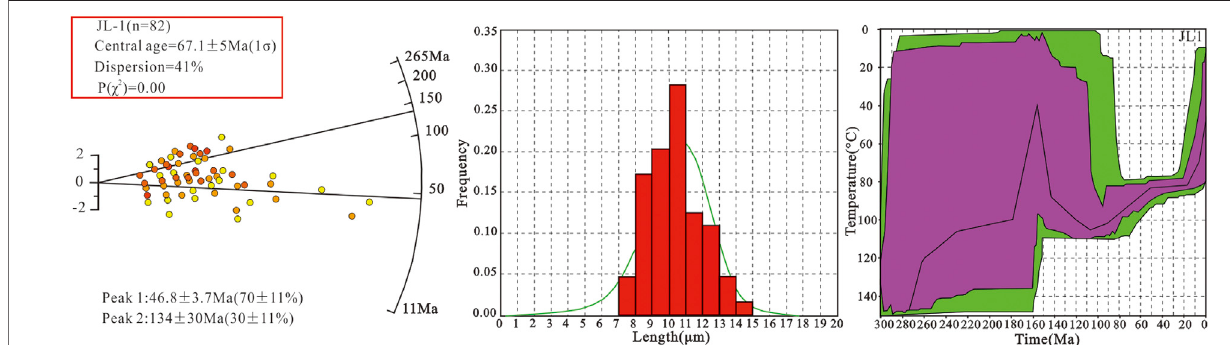
FIGURE 11 | Apatite fi ssion track and thermal history simulation.